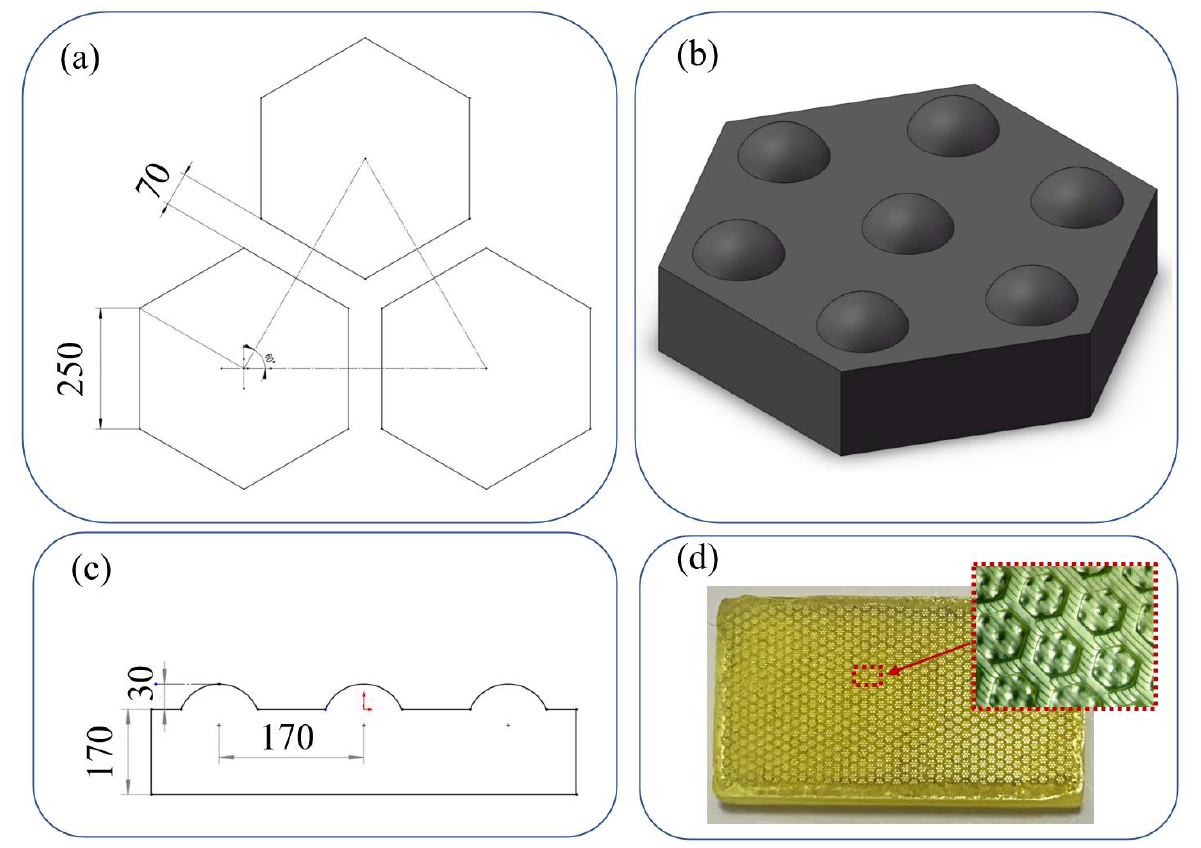
Figure 1. The 2-level microstructure used in the research ( a ) The vertical view of the lower structure ( b ) The 3D view of the 2-level structure ( c )The front view of the 2-level structure ( d ) The female mold and its microstructure.